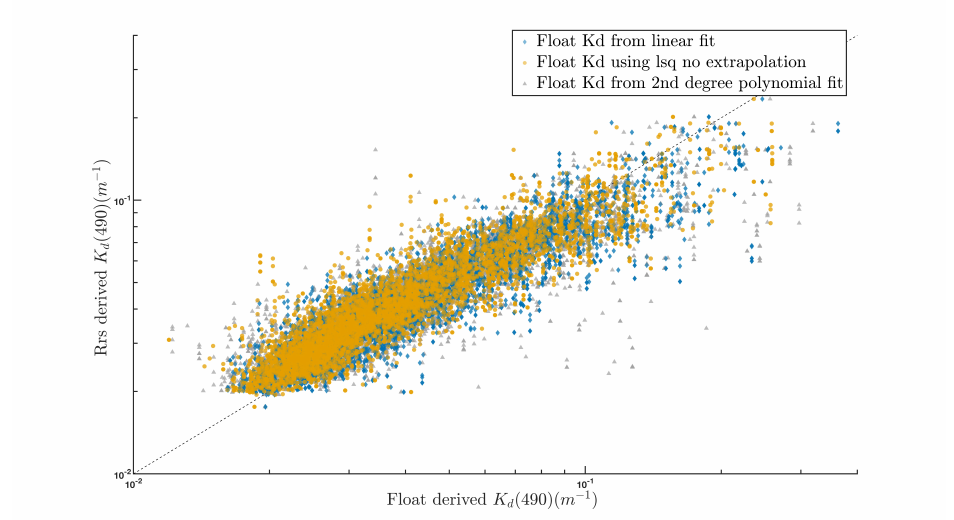
Figure A3. Test of the three potential methods for K d ( λ ) retrieval from E d ( λ ) measured by floats at 490 nm, i.e., a linear fit to extrapolate to E d ( 0 − ) (blue), a second degree polynomial to extrapolate to E d ( 0 − ) (grey) and an iterative least-square fit on existing E d ( 490 ) measurements